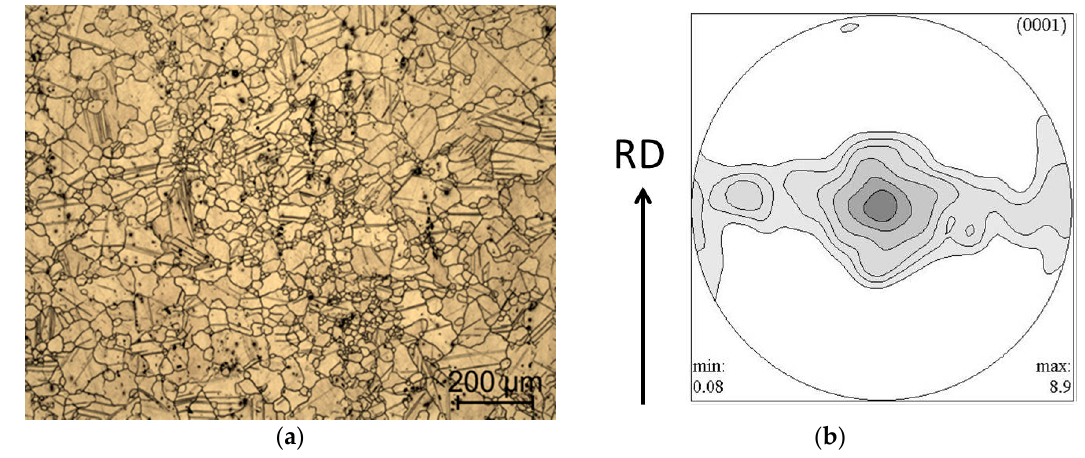
Figure 2. Microstructure of the as prepared AZ31_RS sample ( a ); and the pole figure taken from the sheet surface ( b ).